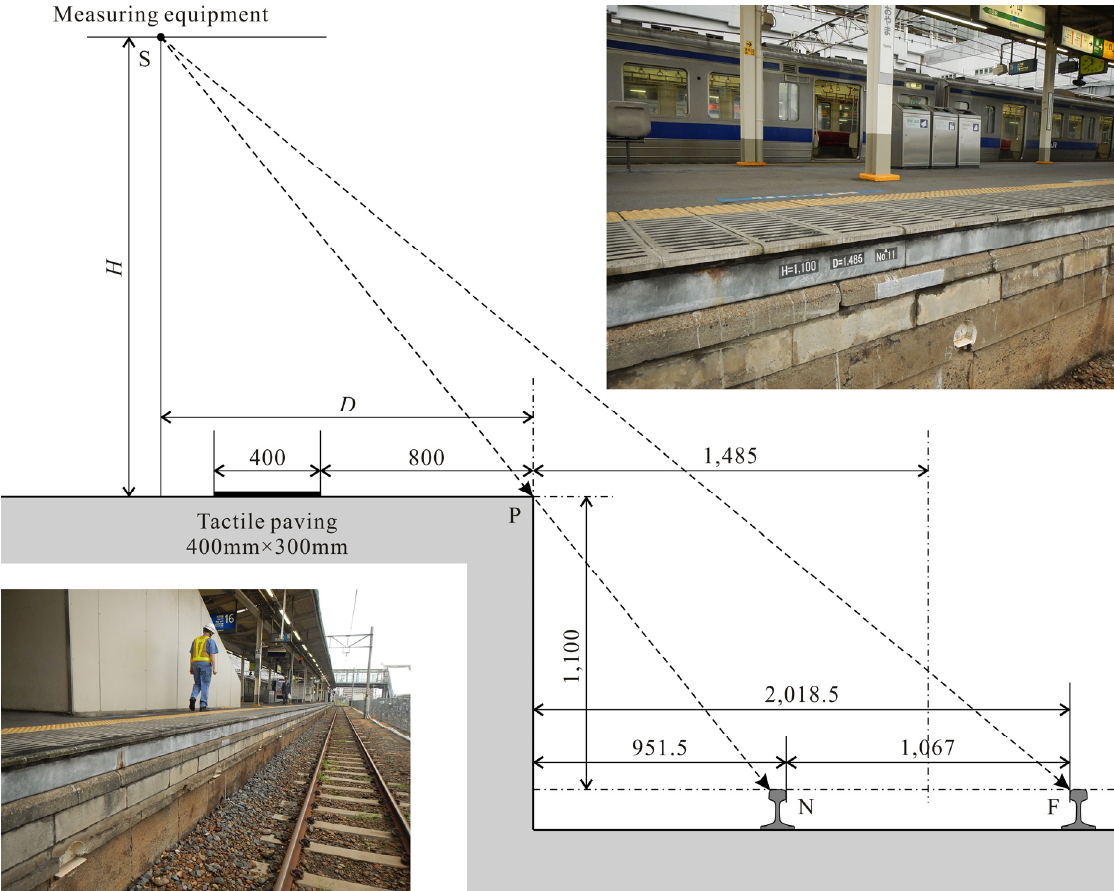
Figure 2. Cross section of a platform (unit: mm)